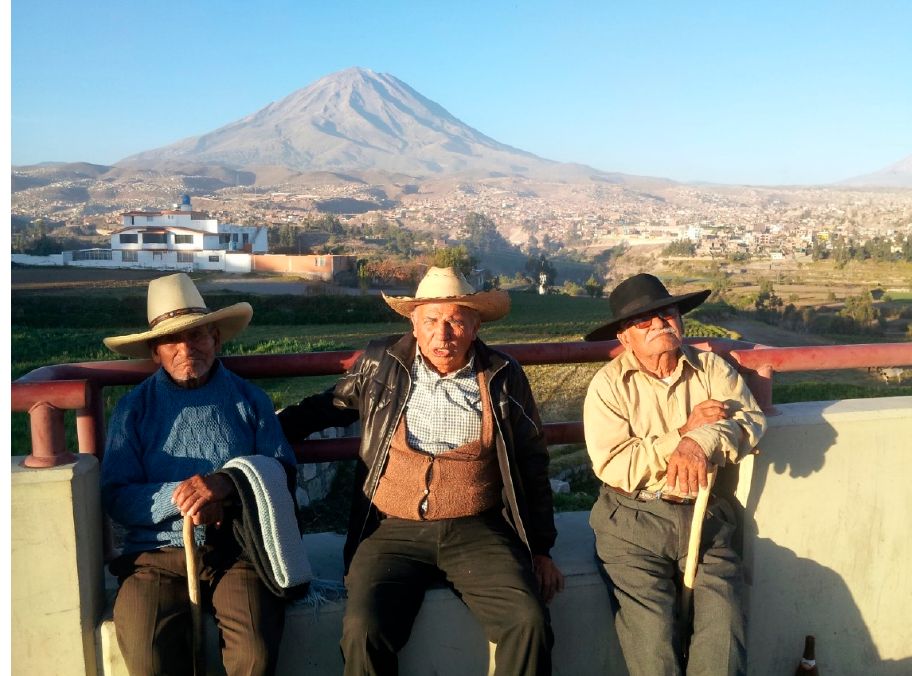
Figure 11. Loncco cattlemen in Carmen Alto pontificating on Mormon land speculation.